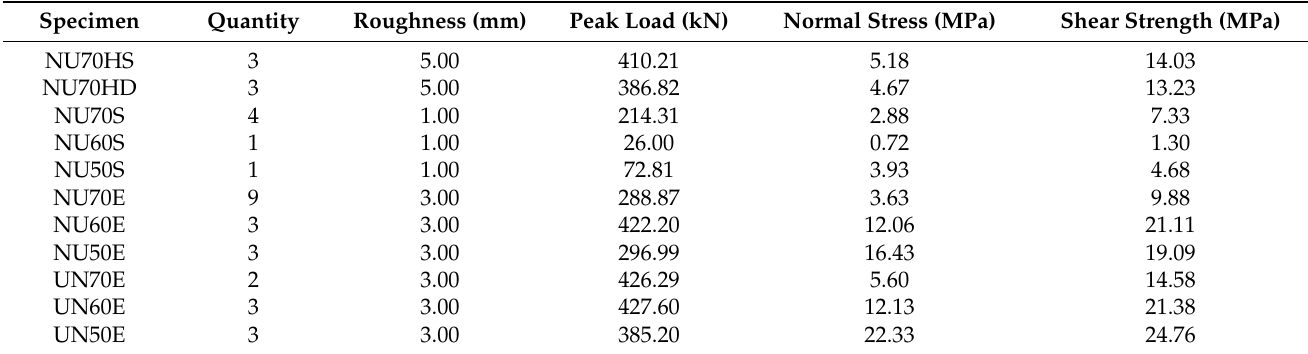
Table 2. Experimental results of “improved” slant shear test.